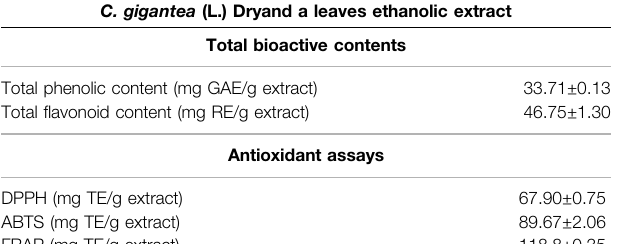
TABLE 1| Total bioactivecontents, antioxidant,and enzyme inhibition activities of ethanolic extract of C. gigantea (L.) Dryand